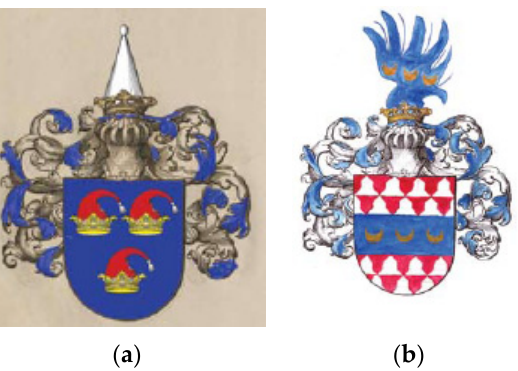
Figure 10. ( a ) CoA of the King of Macedonia High Almain Roll c.1447–55, (emblazon by Jovan Jonovski). ( b ) CoA of the King of Macedonia Miltenberg Wappenbuch c.1475, (emblazon by Jovan Jonovski).